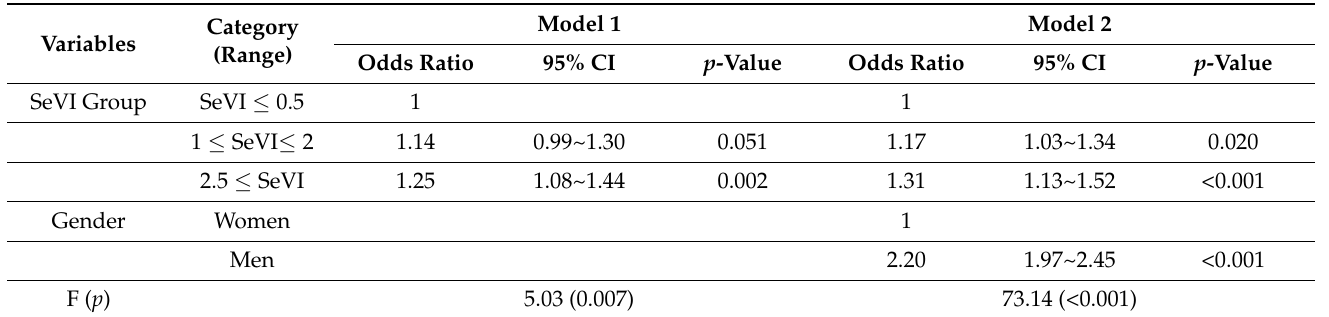
Table 2. Odds ratio for socioeconomic vulnerability index on obesity. N =